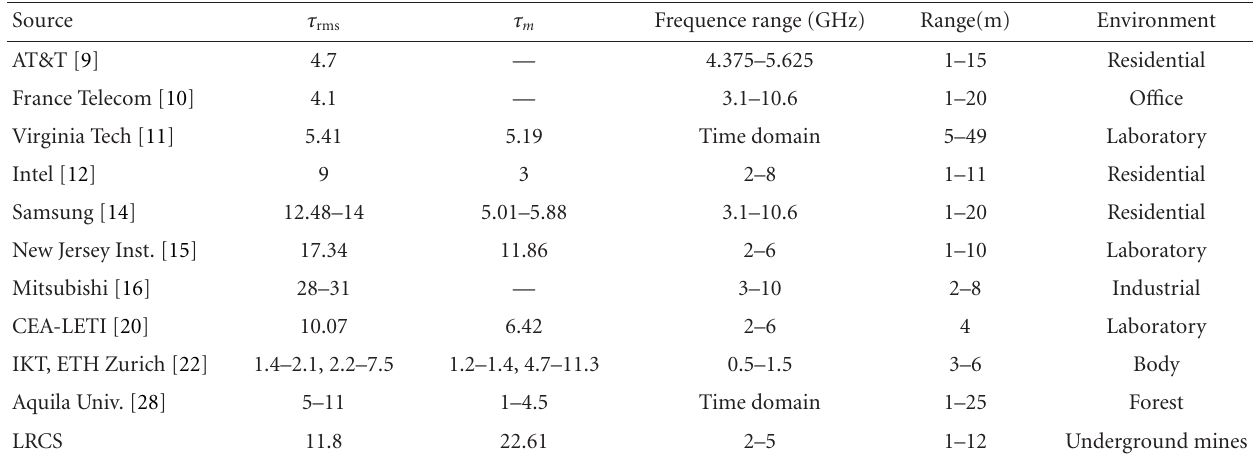
Table 3: Results about time-domain parameters in previous measurement campaigns for LOS case.